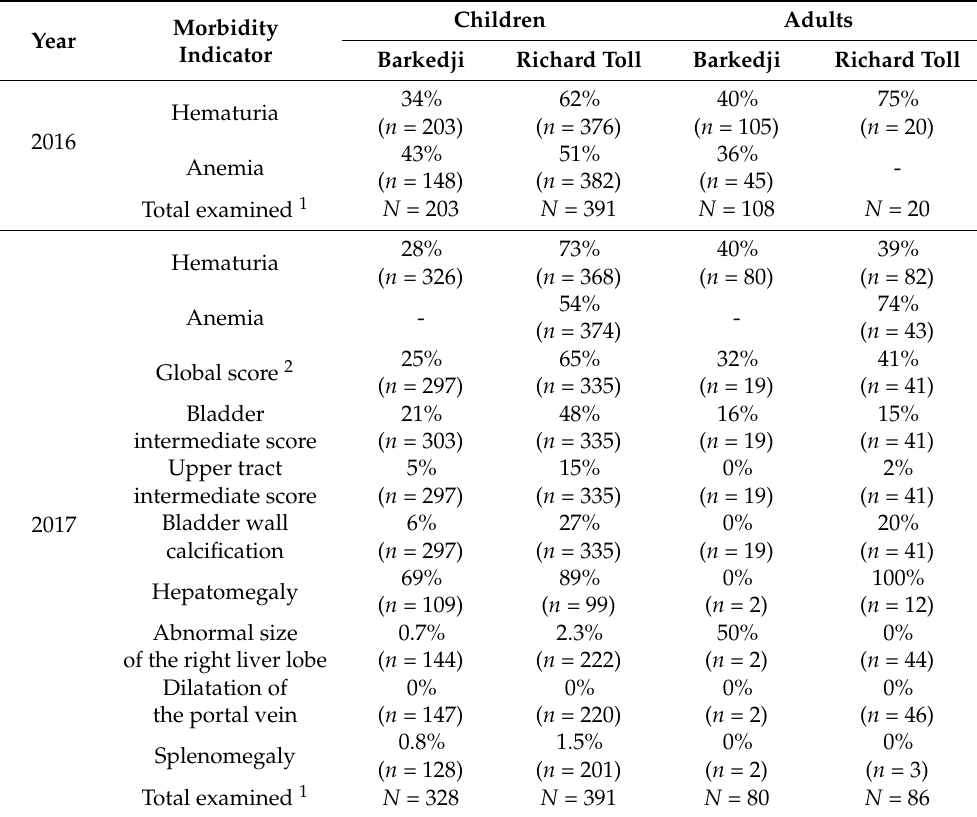
Table 1. Prevalence of morbidity indicators measured in children and adults in two study sites of Senegal in 2016 and 2017 (number of individuals examined indicated in